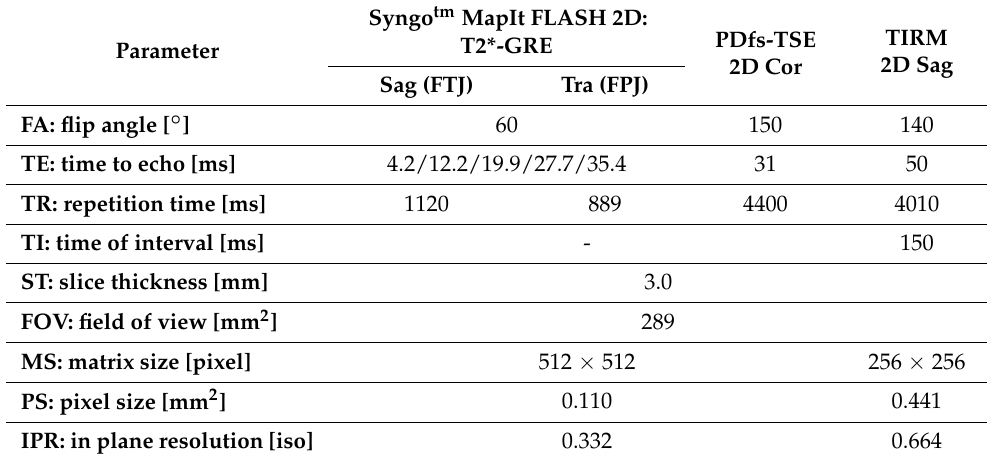
Table 1. MRI protocol parameters of the knee joint.